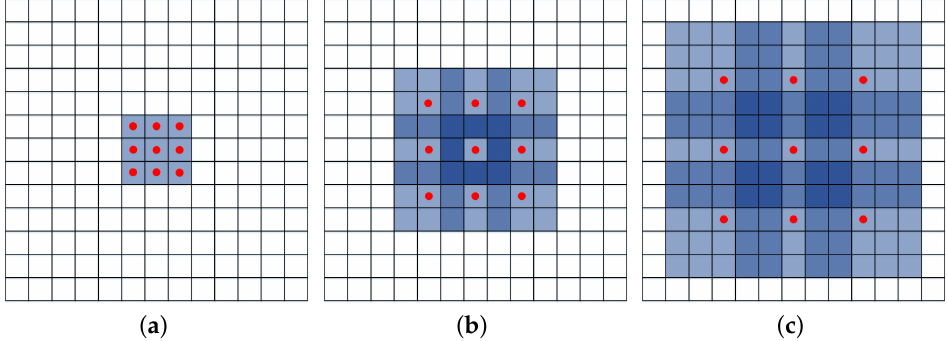
Figure 4. Schematic diagram of different dilated factors. ( a ) The original convolution kernel, with the dilated factor set to 1. ( b ) A convolution kernel with dilated factor of 2. ( c ) A convolution kernel with dilated factor of 3.